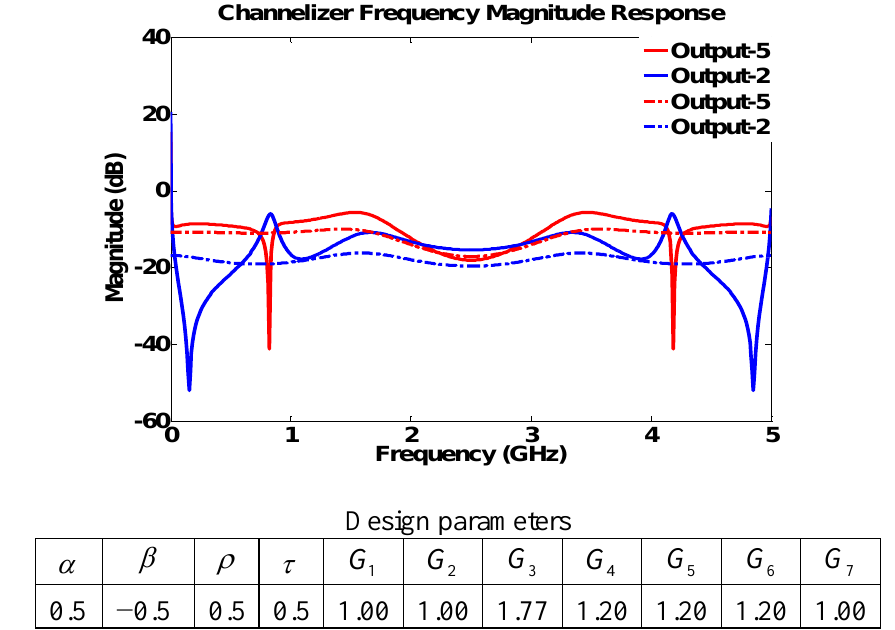
Figure 16. Frequency response using symmetric parameters for structure IV. Solid lines represent output signals with gains. Dashed lines represent output signals with unity